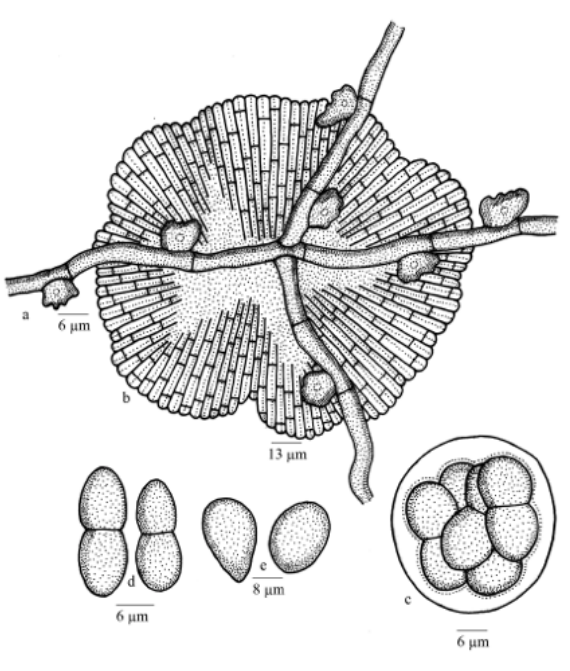
Figure 160. Asterina perpusilla a - Appressorium; b - Thyriothecium; c - Ascus; d - Ascospores; e -